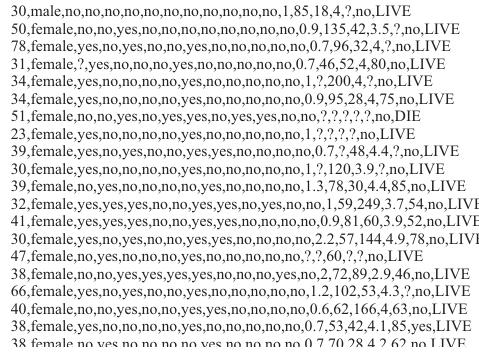
Fig. 13. A part of the “hepatitis.arff” dataset